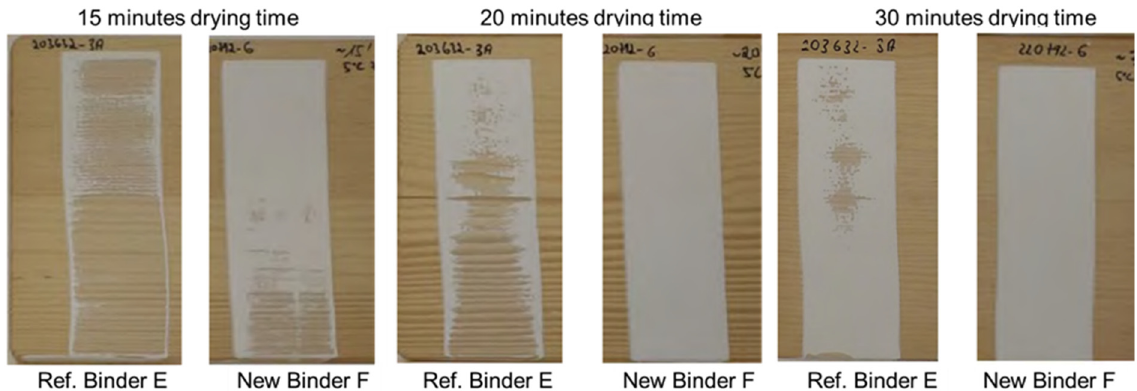
Figure 10. ERR test of white wood paints, formulated according to Table A3 and tested according to Section 2.2. The temperature during drying was 5 °C, and the humidity was approximately 75%.